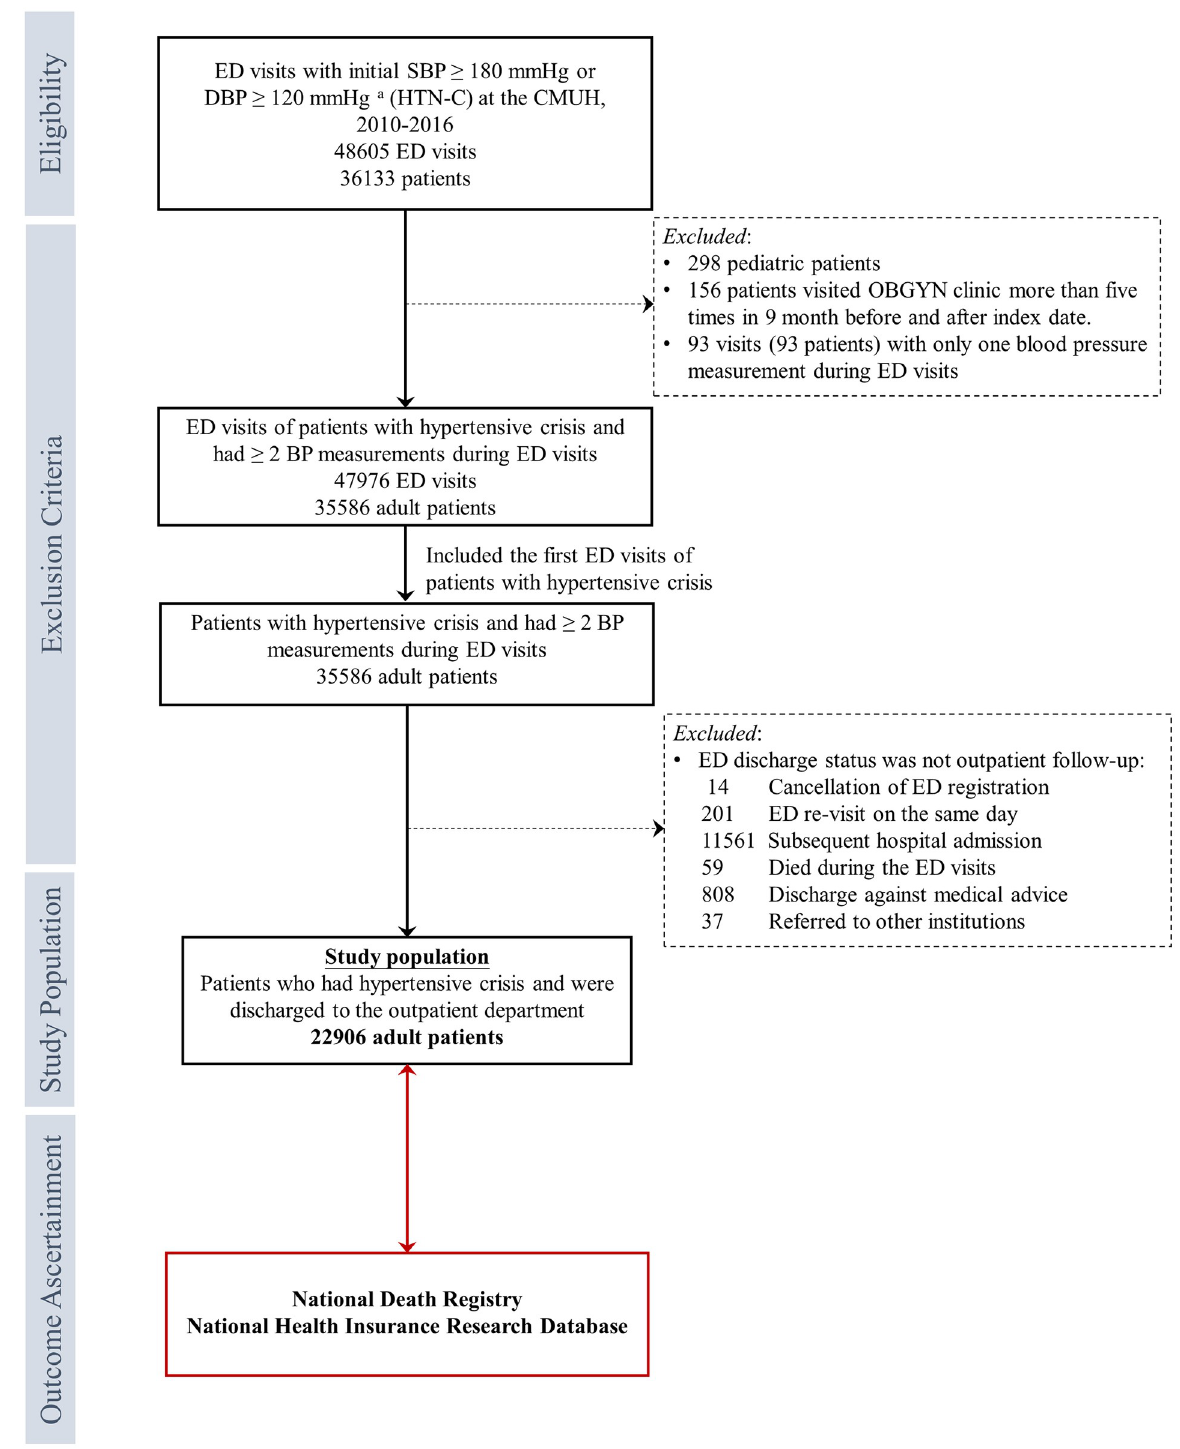
Fig 1. Selection process of the study population. Abbreviations: BP, blood pressure; CMUH, China Medical University Hospital; DBP, diastolic blood pressure; ED, emergency department; HTN-C, hypertensive crisis; SBP, systolic blood pressure. SBP measurements less than 50 mm/Hg or higher than 270 mm/Hg were excluded. DBP measurements less than 30 mm/Hg or higher than 160 mm/Hg were excluded.